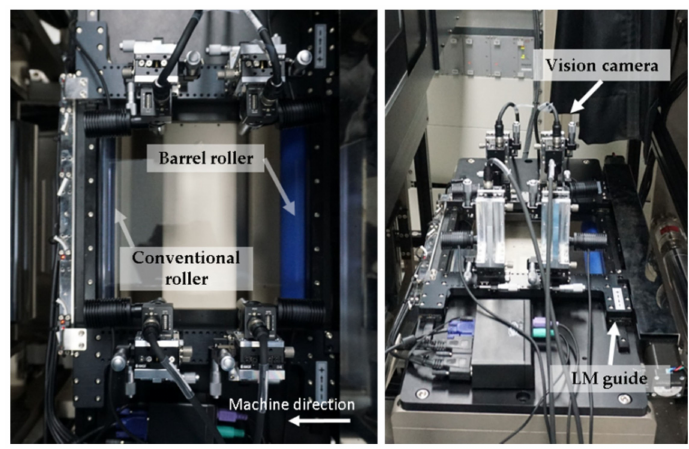
Figure 14. Schematic of web strain measurement (top view) with a barrel roller.